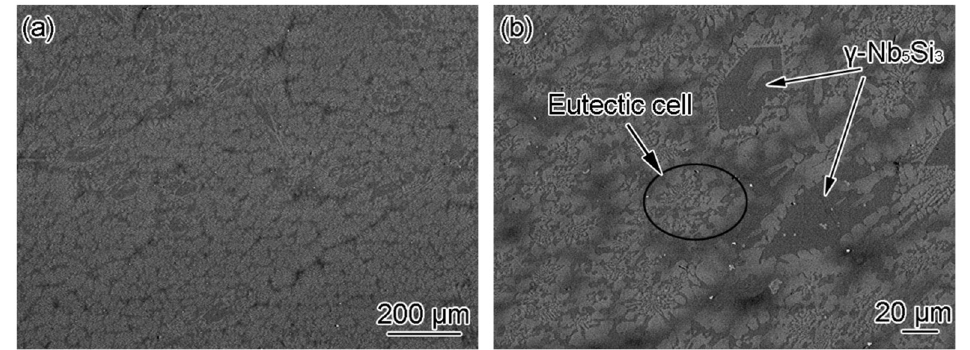
Figure 2. Back-scattered electron (BSE) images of the microstructure of the as-cast master alloy under different magnifications: ( a ) 200× and ( b ) 1000×.